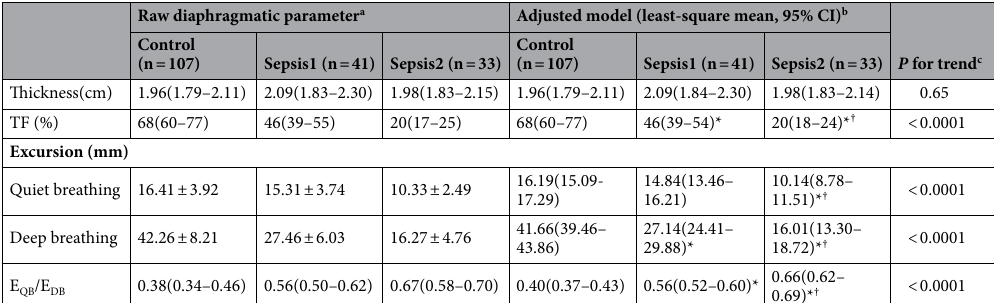
Table 2. Diaphragmatic thickness and excursion measured by ultrasound in three groups. The above analyses were adjusted for sex, age, BMI, MAP, hypertension and diabetes, rather than using the raw data of diaphragmatic parameters directly. * P < 0.05 compared with control group; † P < 0.05 compared with sepsis group 1. a All raw data was presented as median (IQR) or mean ± SD for continuous variables. b The adjusted least-square mean and 95% CI were calculated by covariance analysis (CI = confidence interval). c P for trend of diaphragmatic ultrasound parameters across sepsis severity were calculated based on generalized linear models.